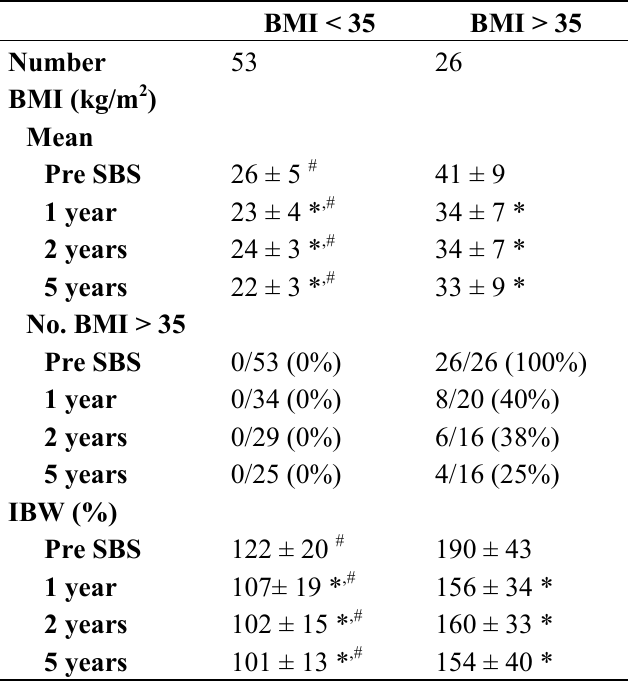
Table 4. Comparison of body mass index.